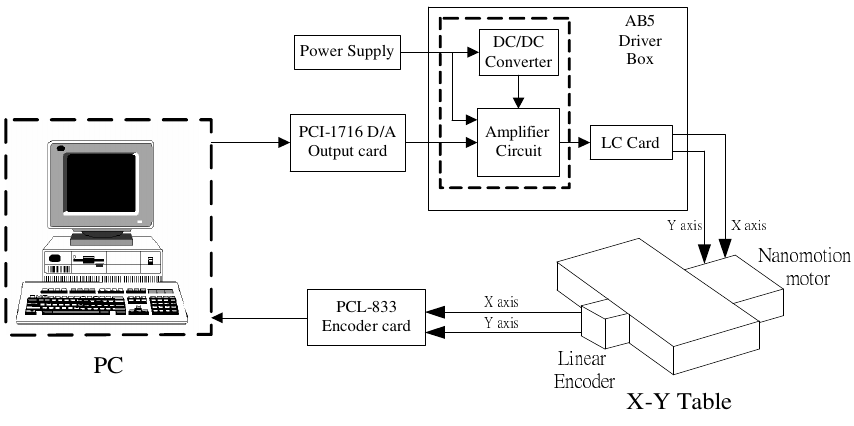
Figure 2. Positioning control system experimental